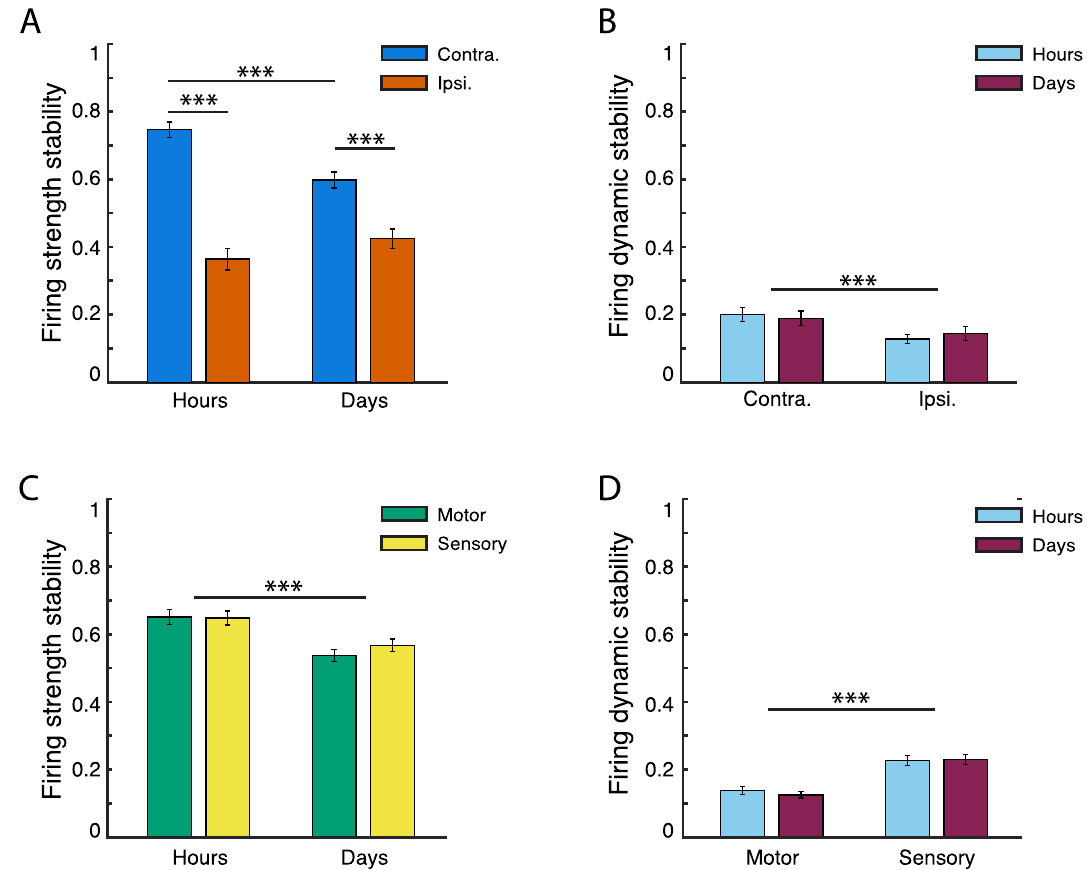
Figure 4. Within-channel (MUA) stabilities of left-ECR-related activity over time. X-axis denotes time scale of comparison (H: hours; D: days). Y-axis measures are normalized to the range [0, 1], higher values denoting greater stability. Bars show mean values + /- 1 SE. (*), (**), and (***) denote significance levels of 0.05, 0.01, and 0.001 respectively. ( A ) Firing strength stability significantly decreased from hours to days, and was higher for contralateral than ipsilateral channels. There was a significant hemisphere—by–timescale interaction, with a significant decrease in contralateral channel stability as the period between recordings varied from hours to days, but no corresponding significant difference in ipsilateral stability over timescale. ( B ) Firing dynamic stability (cross-correlation between z-scored PETHs) did not significantly decrease from hours to days in both hemispheres. There was a significant main effect of brain hemisphere, with contralateral channels being more stable than ipsilateral across hours and days. ( C – D ) Comparative stability across areas, pooled over brain hemisphere. ( C ) Firing strength stability (relative change in z-score of firing rate) by cortical area, over time. Stability significantly decreased over time from hours to days, with no significant difference between cortical areas. ( D ) Firing dynamic stability was invariant within areas from hours to days, but was significantly higher in sensory than motor When comparing firing dynamic stability for the left ECR between hemispheres, we found a significant main effect of hemisphere only (F(1,764) = 13.21, p < 0.001), with the contralateral being more stable than the ipsilateral (mean difference = 0.098, p < 0.001). For the right ECR also, the contralateral hemisphere had higher average stability (mean difference = 0.020) although there were no significant main effects of hemisphere or time. Comparing firing dynamic stability between area and timescale for left ECR, we observed a significant main effect for area only (F(1,764) = 56.81, p < 0.001; Fig. 4D), sensory channels being more stable than motor (mean difference = 0.0974, p < 0.001). Right-ECR-related activity likewise exhibited a significant main effect for area (F(1,854) = 6.80, p = 0.009; Fig. S6D), with higher stability in sensory cortex than motor (difference = 0.0357, p = 0.012). In sum, firing dynamic stability was higher in the contralateral hemisphere (for the left ECR), and higher for sensory channels than motor (left and right ECRs).